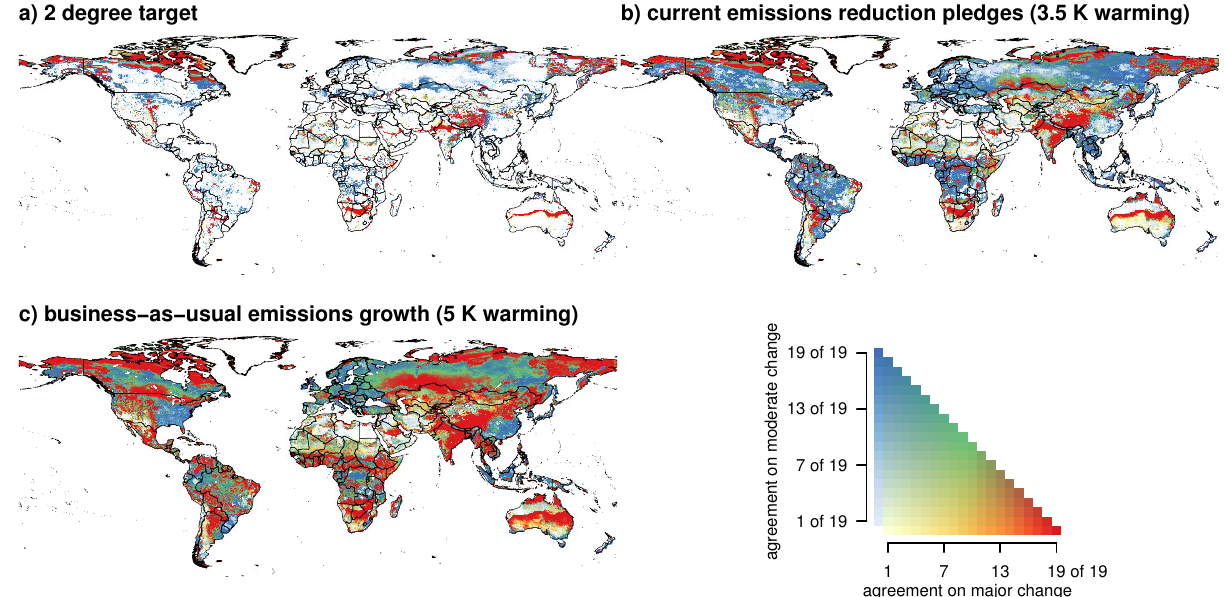
Fig. 2. Regional patterns of simulated ecosystem change by 2100 and their confidence, for different climate policies leading to a GMT increase of 2, 3.5 and 5K above preindustrial, respectively. Colours indicate the number of simulations agreeing on either major ( 0 > 0.3) or moderate ecosystem change (0.1 <0 < 0.3) in each grid